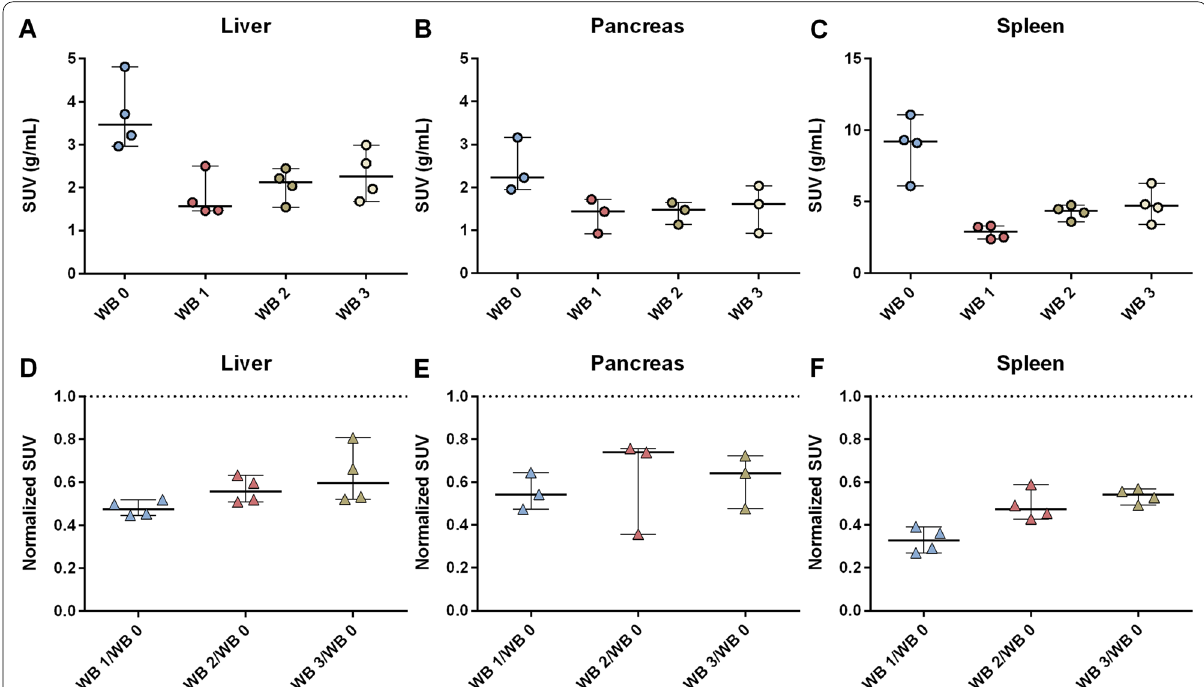
Fig. 5 Scatter dot plots of SUV at baseline (WB 0), WB 1 (0 h), WB 2 (4 h) and WB 3 (7 h) in ( A ), liver ( B ) pancreas and ( C ) spleen. Normalized SUV, where SUV in WB 1, 2 and 3 is normalized against SUV at WB 0 (SUV ratio) in ( D ) liver, ( E ) pancreas and ( F ) spleen. The solid line represents median and range and the dotted line the normalized SUV value of 1. Following the initial SUV drop from baseline (WB 0) to WB1 (0 h), a slow recovery was found during WB 2 (4 h) and WB 3 (7 h), but not back to baseline levels